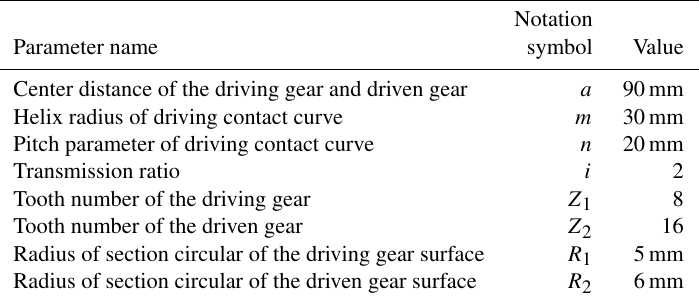
Table 1. Design parameters of the NHGM sample.